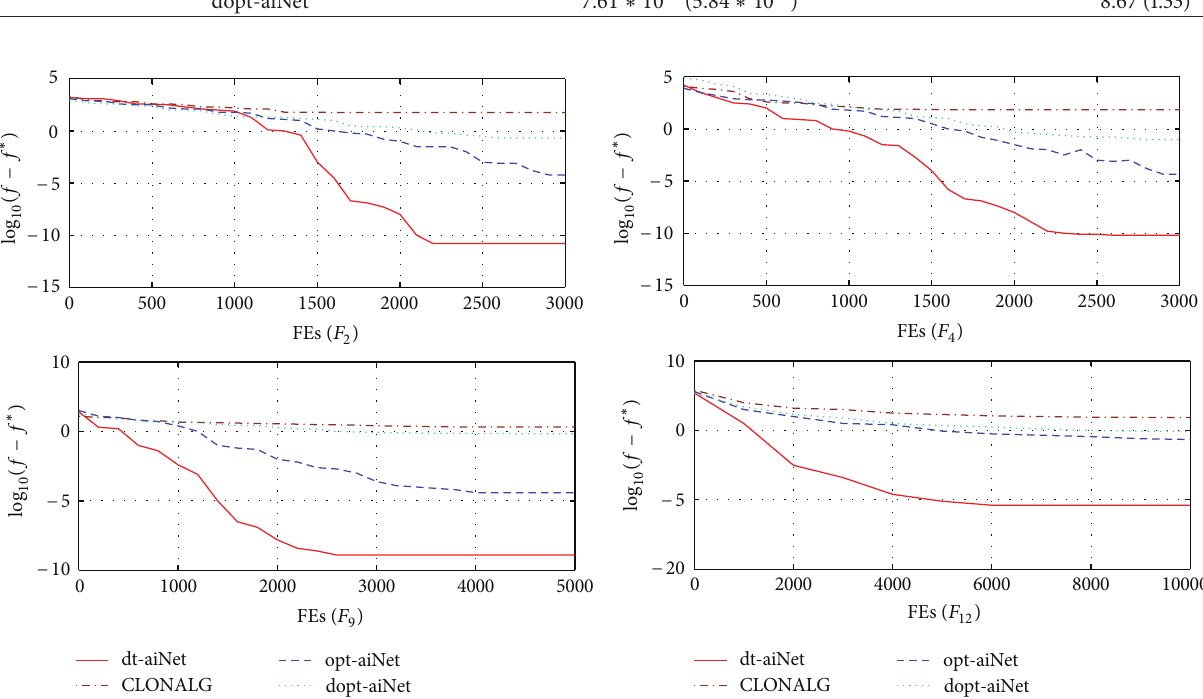
Figure 3: Convergence graphs in 2-dimensional